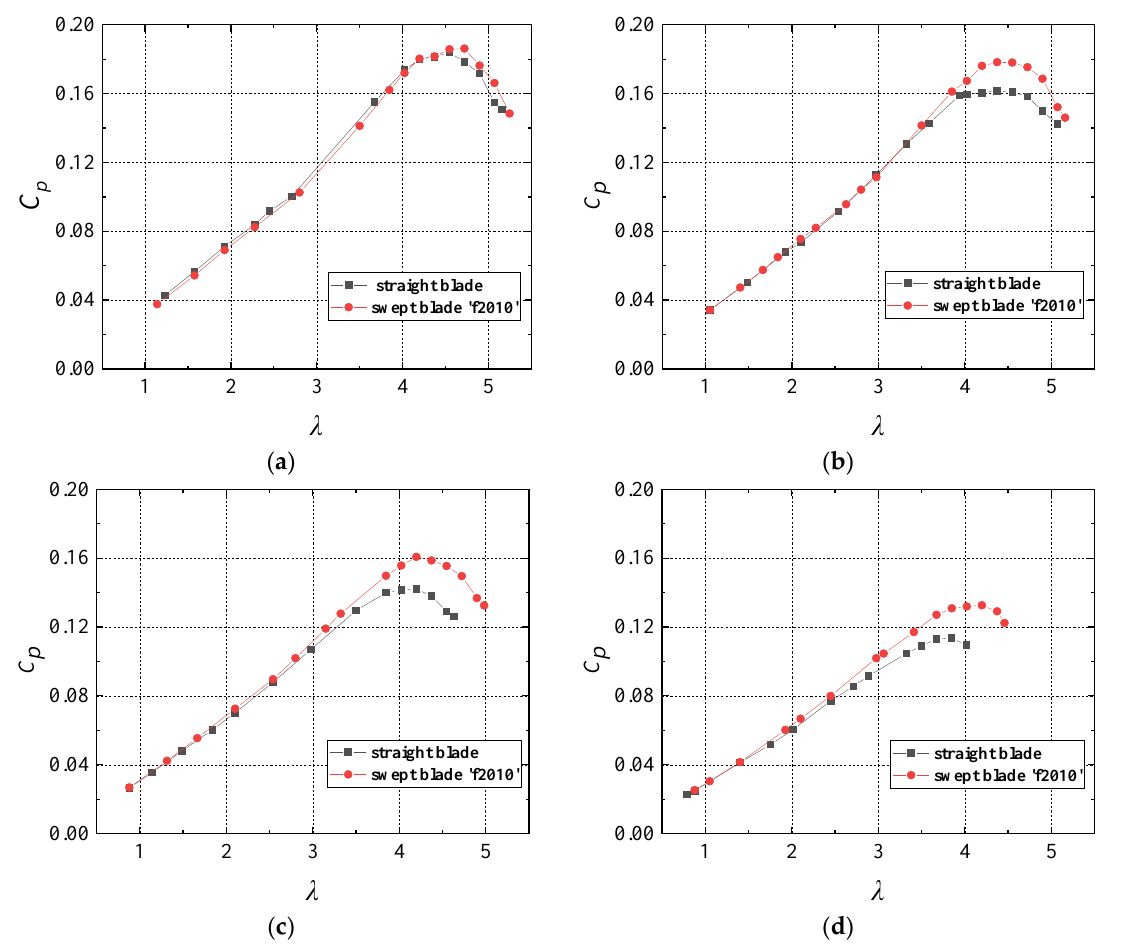
Figure 11. Wind turbine power characteristic curves at different yaw angles. ( a ) 0°; ( b ) 10°; ( c ) 20°; ( d ) 30°.